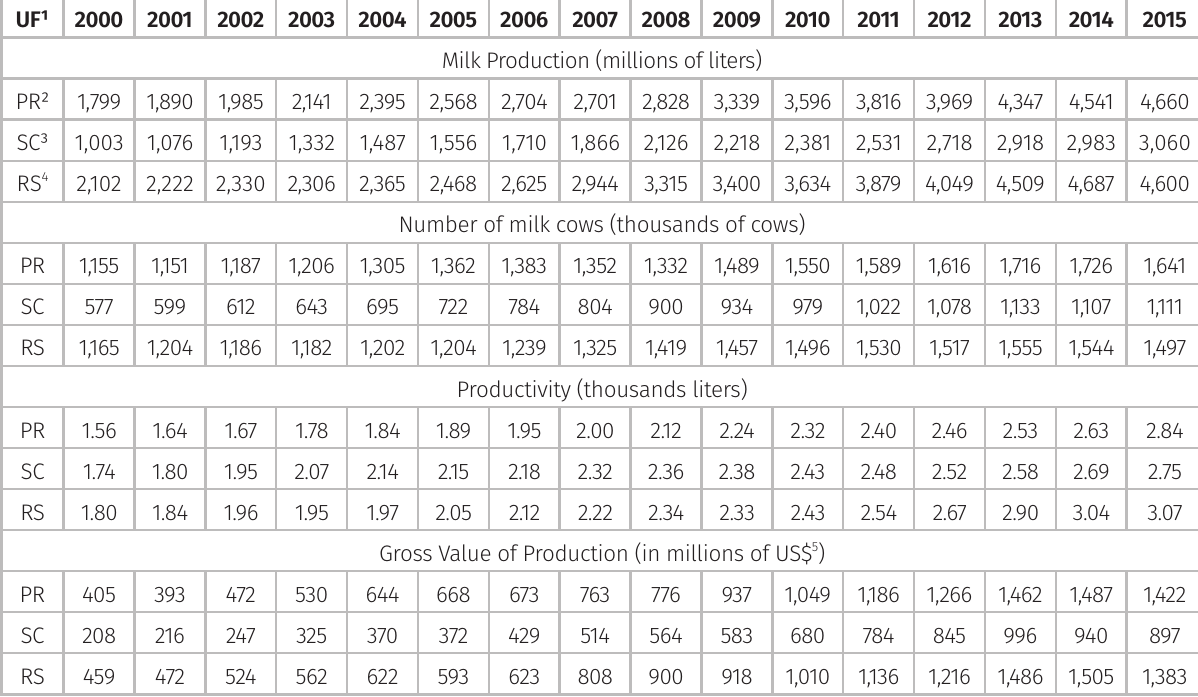
Table I. Evolution of milk production, number of milk cows, productivity and gross value of production for states in Southern